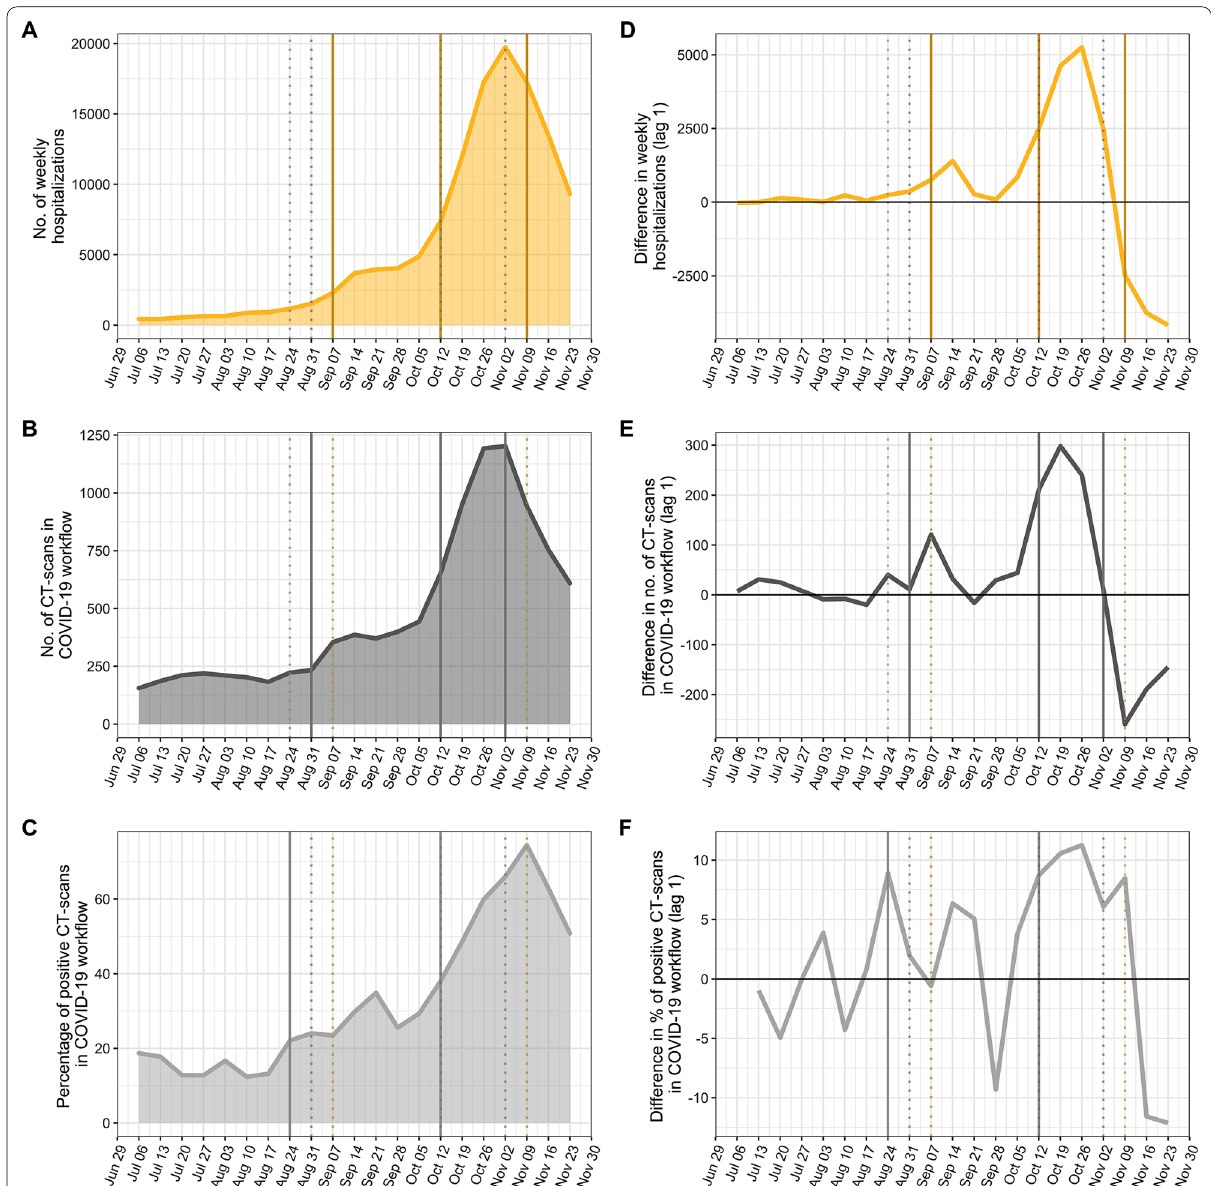
Fig. 4 Assessment of breakpoints after the first wave on the following weekly time series: ( a ) no. of hospitalisations, ( b ) no. of CT‑scans performed in the COVID‑19 workflow by teleradiologists during on‑call duty, ( c ) percentage of compatible CT‑scans in the COVID‑19 workflow. On each plot, the solid vertical lines correspond to the significant breakpoints. The dotted lines correspond to the significant breakpoints for the other time series. ( d–f ) illustrates the lagged difference ( X ( t ) – X( t 1)) for the three series, respectively, highlighting a spike between the weeks of 2020‑08‑24 and −